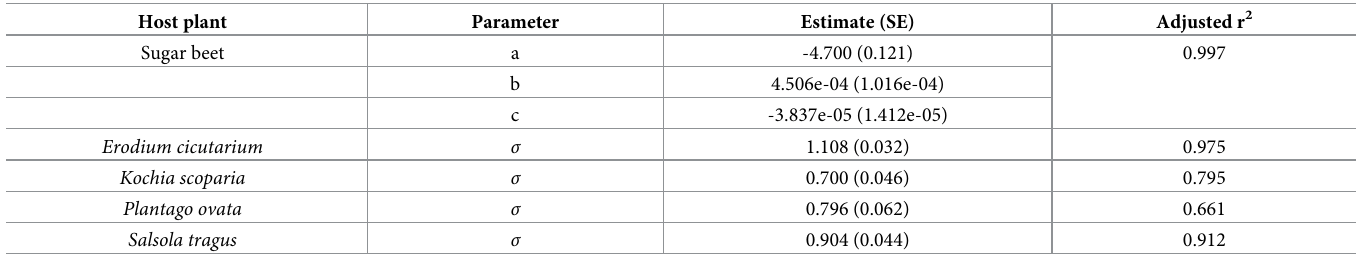
Table 3. Estimated parameters in female aging rate models of beet leafhoppers on five host plant species. Host